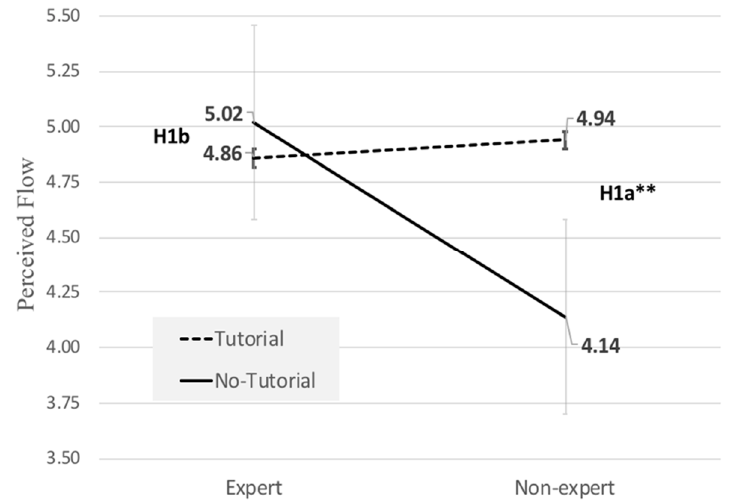
Figure 4. Perceived flow as a function of player expertise and tutorial.